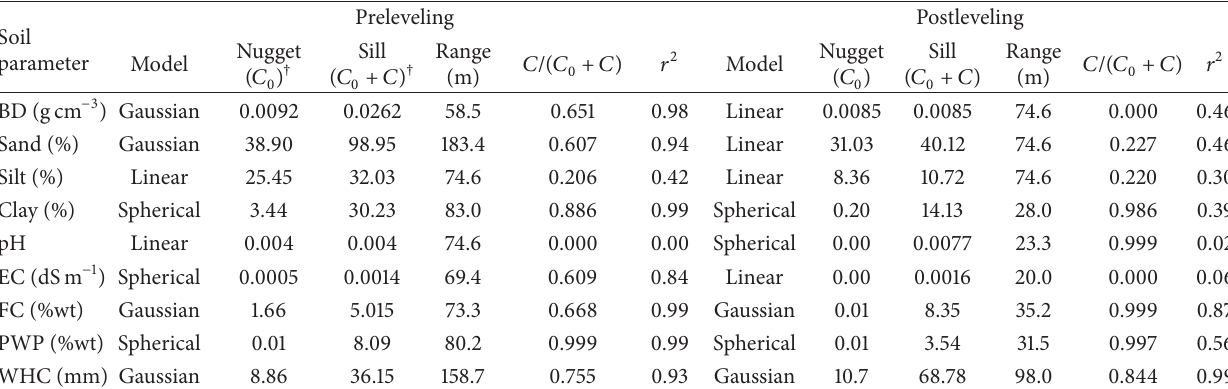
Table 3: Summary of geostatistical parameters for surface soil (0–20 cm) properties measured before and after land leveling. Soil